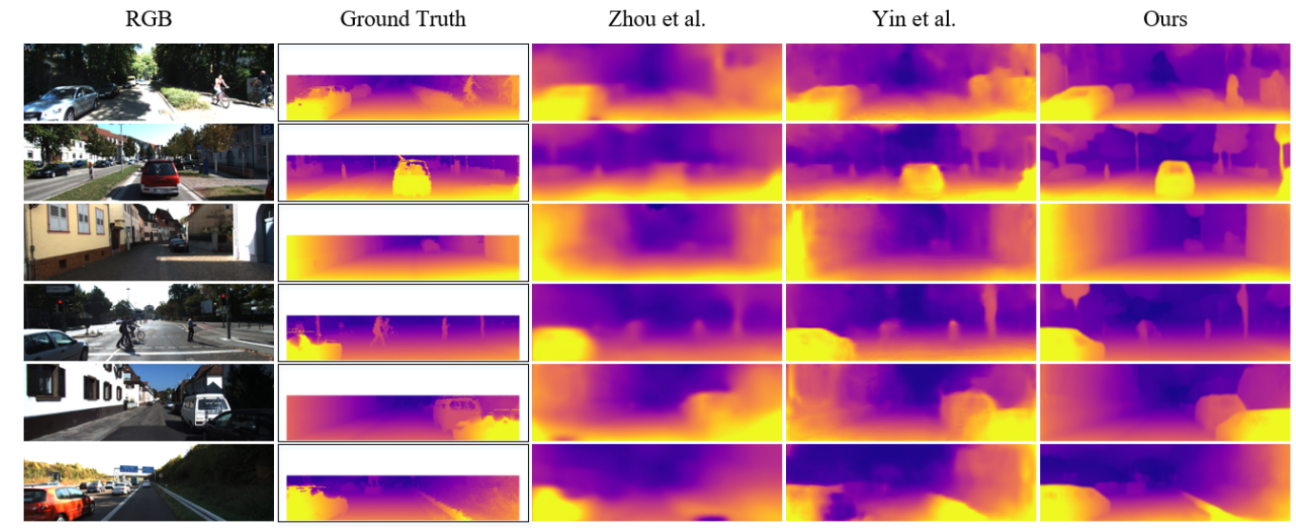
Figure 4. Depth examples of the unsupervised methods Zhou et al. [16], Yin et al. [21] and ours on KITTI dataset. The ground truth is interpolated for visualization.